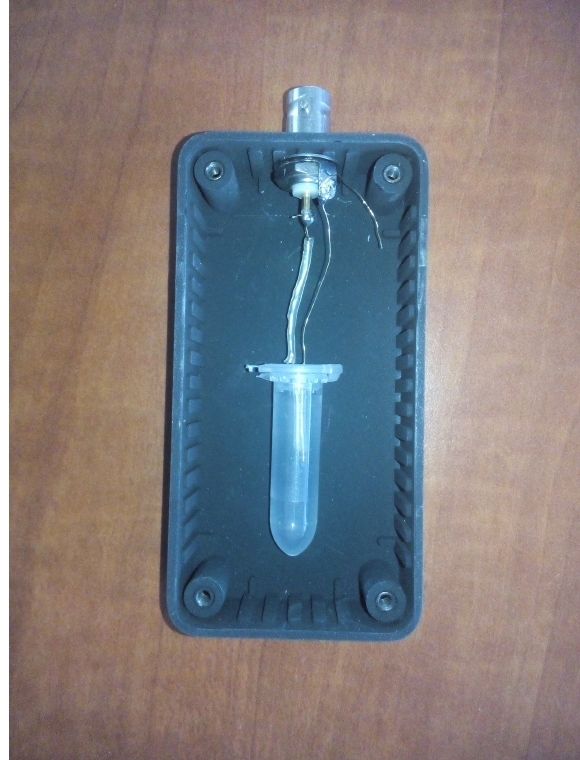
Figure 12. The detector inside the boron plastic box (the third